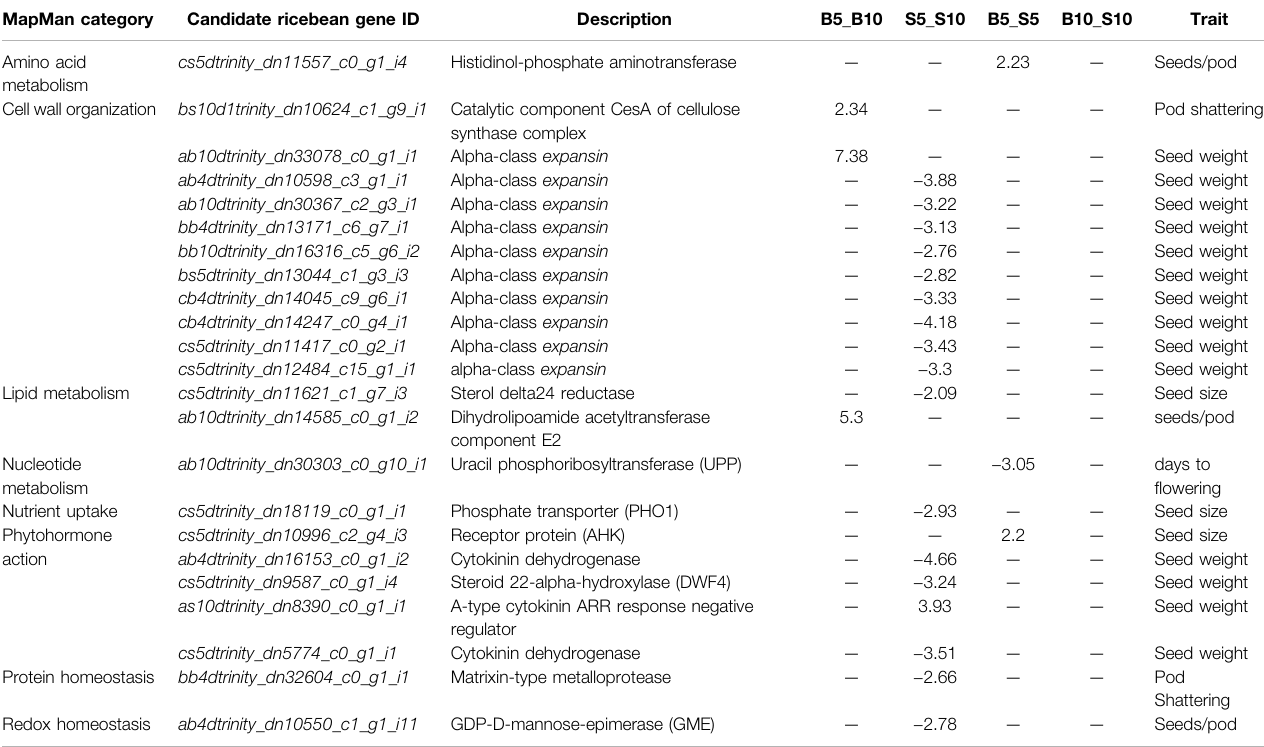
TABLE 3 | List of candidate genes matched with our MapMan results. MapMan